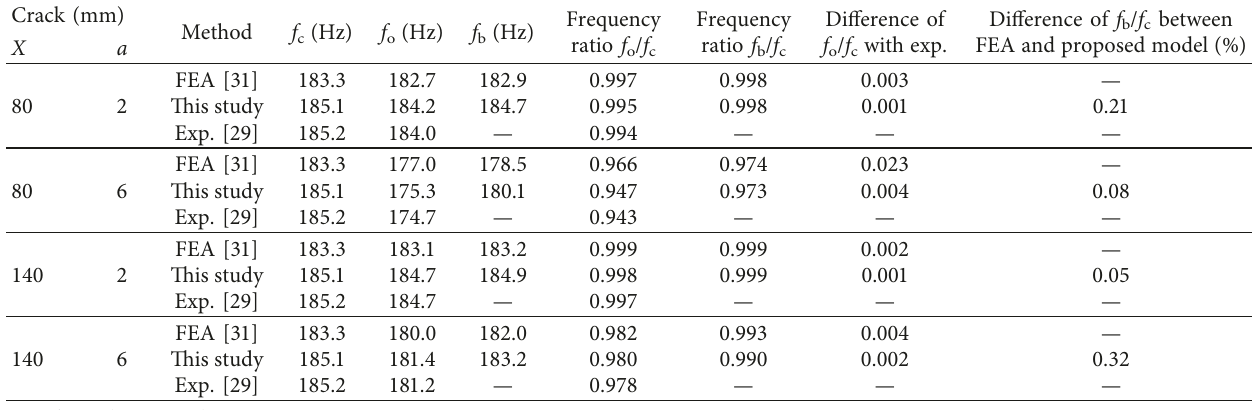
FEA: finite element analysis.